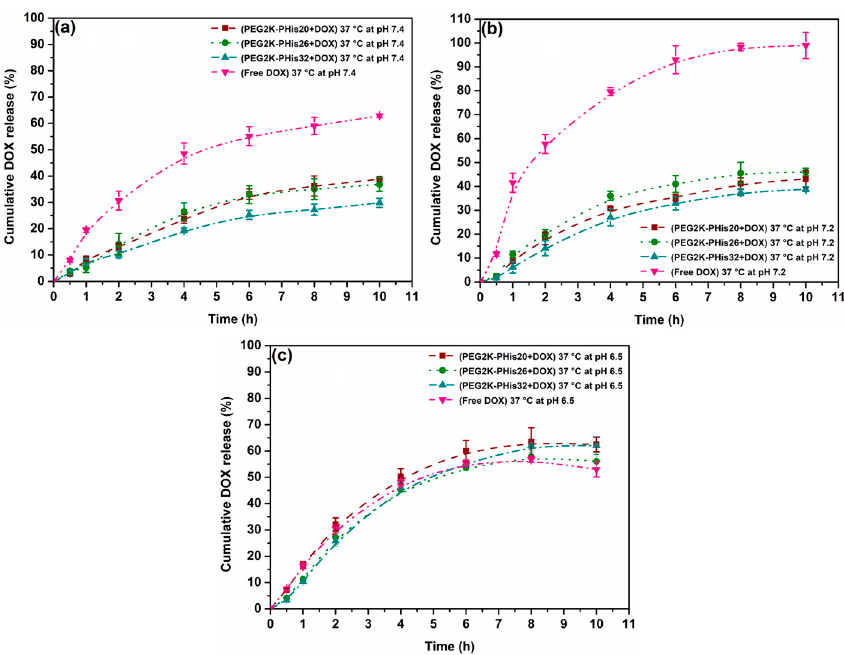
Figure 7. Drug release profiles of DOX-loaded micelles and free DOX in 1X PBS at pH 7.4 ( a ), pH 7.2 ( b ), and pH 6.5 ( c ) at 37 °C.